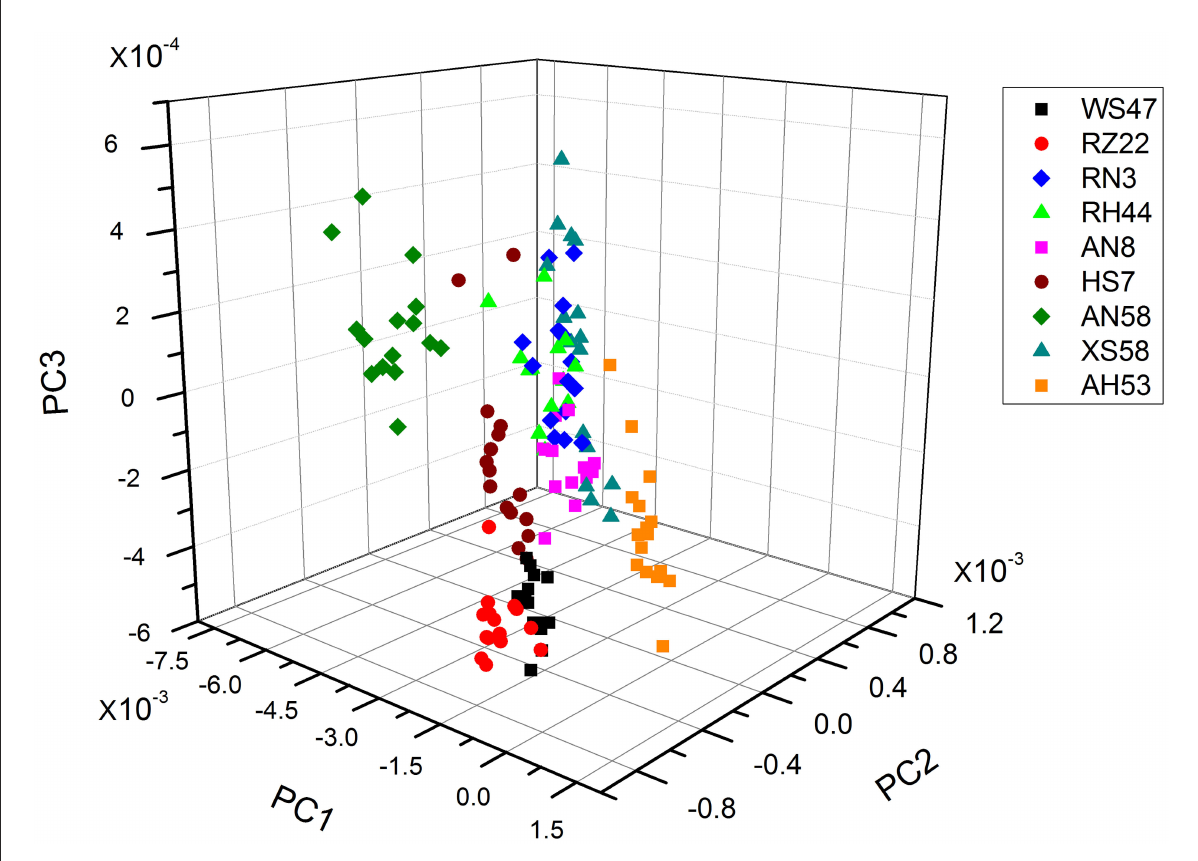
FIGURE5 PCA results of the carotenoids and lipids region (ca. 1,700–1,500 cm − 1